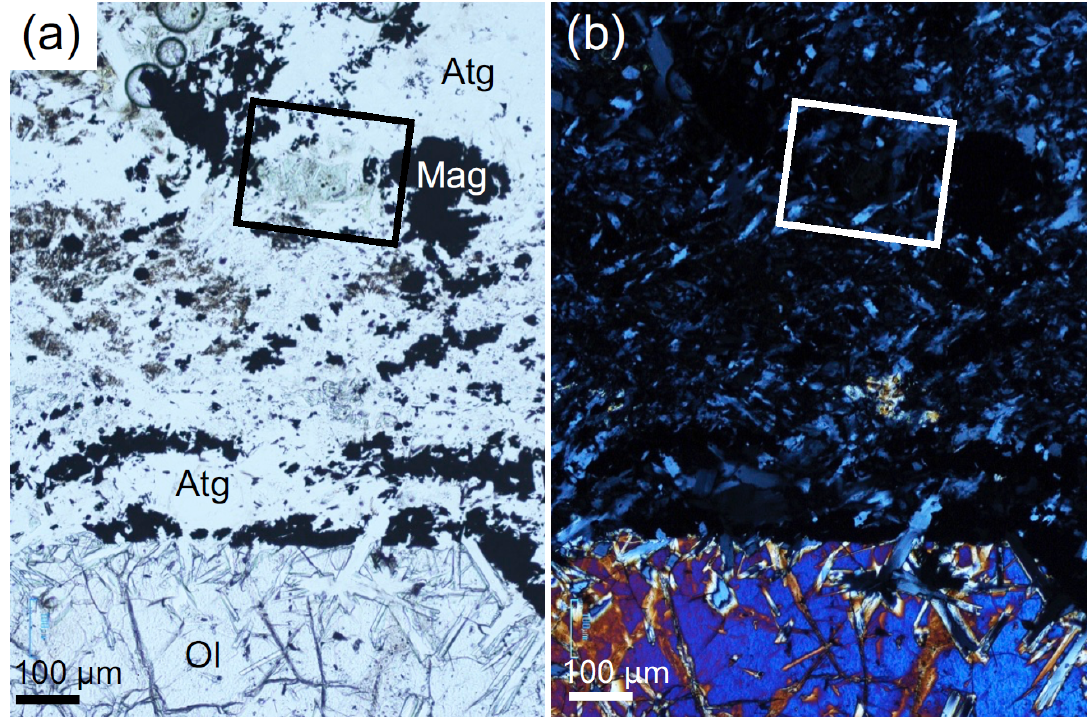
Figure 2. Photomicrographs of the partially serpentinized dunite that contains theophrastite-zaratite aggregates from Fujiwara, the Sanbagawa metamorphic belt, southwest Japan. Atg, antigorite. Mag, magnetite. Ol, olivine. ( a ) Antigorite-rich part with relic olivine. Note the penetration of antigorite laths into olivine. Plane-polarized light. The theophrastite-zaratite aggregate was found in the rectangle, which is enlarged as Figure 3. ( b ) Crossed-polarized light image of ( a ).